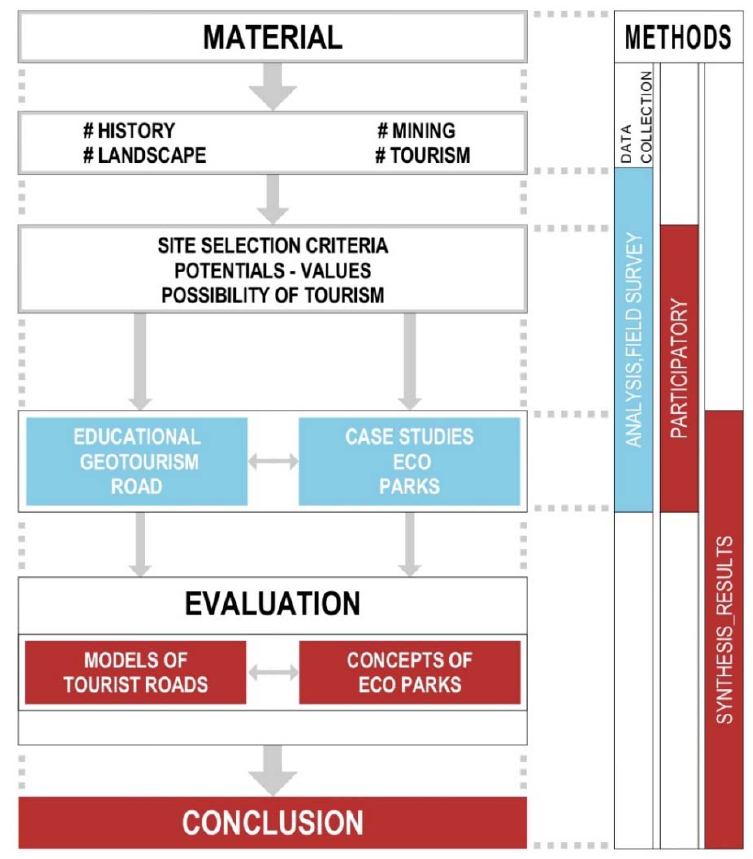
Figure 4. Diagram of the research method (figure from the author).